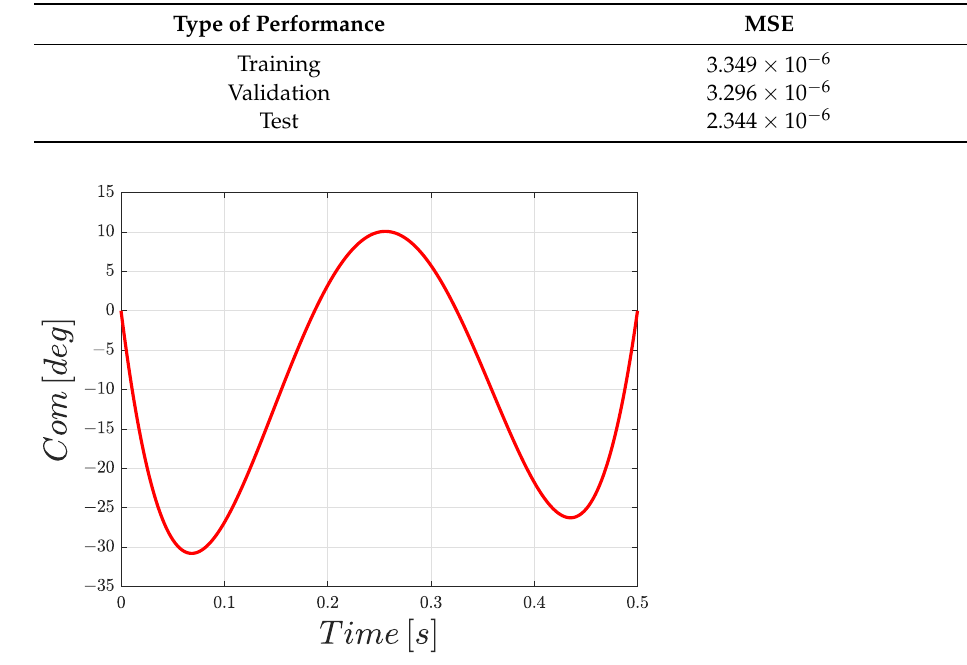
Figure 15. One of elevator command curves used when testing the generalization of Case